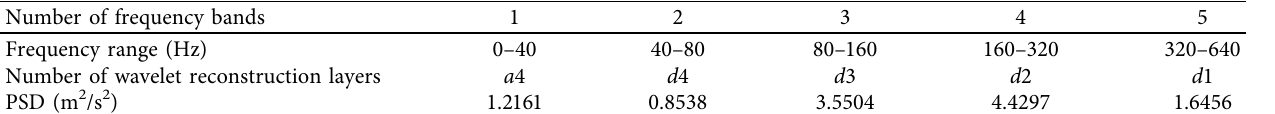
Table 3: Average value of PSD in each frequency band at 50cm measuring point.